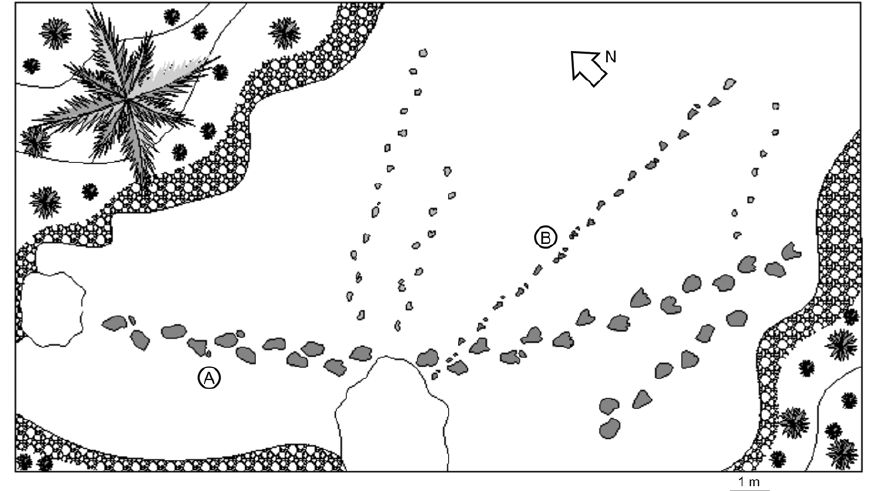
Fig. 3 – Trackway map of ichnotaxa A and B showing spatial relation between both ichnotaxa trackways.